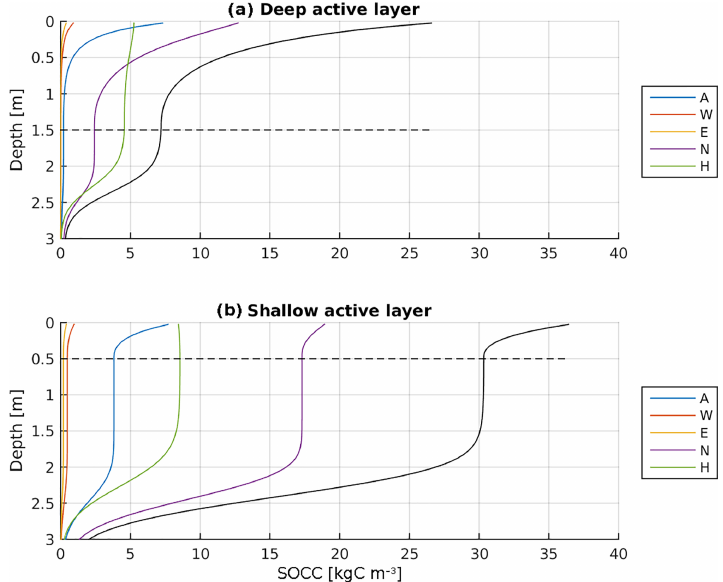
Figure A11. Simulated SOCC profiles inferred from the process-based model of vertical SOM dynamics. The coloured curves represent different SOM lability classes according to YASSO, separated into fast (A, W, E), intermediate (N), and slowly decomposing (H) compounds. The black line shows aggregated total SOC. The horizontal dashed lines indicate ALD, and determine SOCC i 20kyr using a cryoturbation rate of 10cm 2 yr − 1 , a sedimentation rate of 10cmkyr − 1 , decomposition timescale parameters set to YASSO standard values, and using a litter input of 100gCyr − 1 m − 2 (a) and 200gCyr − 1 m − 2 , respectively (b)